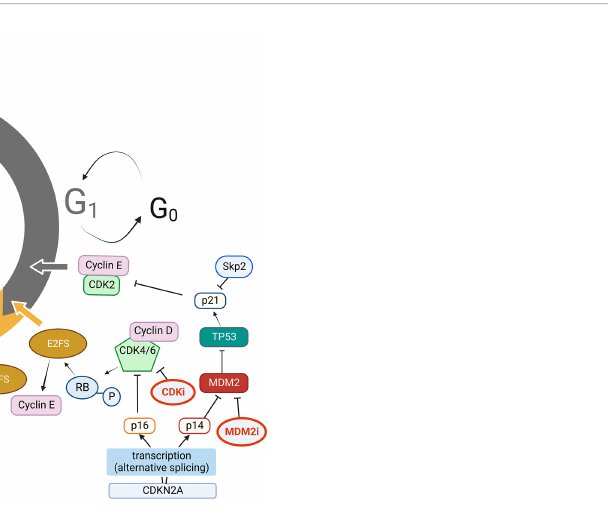
FIGURE 1 Key players in cell cycle dysregulation in STS. CDK, Cyclins, CKI, and other key molecular players in CDK activity/inhibition. Clockwise, starting from G1 to S phase progression: CDKN2A is transcribed by alternative splicing either into p16 or p14, which respectively inhibit CDK4/6/Cyclin D complexes and MDM2 activity. MDM2, an ubiquitin ligase, ubiquitinates p53 targeting it to the proteasome; p53 has p21 as a direct transcriptional target, and p21 in turn inhibits CDK2/Cyclin E complexes. Cyclin E expression is regulated by E2F transcription factor, which in turn is released from Rb protein grip (usually blocking its transactivation domain) when CDK4/6/Cyclin D complexes phosphorylate Rb, facilitating G1 to S phase progression. The ubiquitin ligase Skp2 targets p21 and p27 for proteasomal degradation, thus promoting CDK2/Cyclin E, CDK2/Cyclin A activity in S phase progression, CDK1/Cyclin A activity for G2 to M transition, which is also fostered by releasing p21 inhibitory activity on CDK1/Cyclin B; DUX4 can also bind CDK1, thus preventing CDK1/Cyclin B interaction. MDM2 activity can also be inhibited with MDM2 inhibitors (MDM2i), while CDK inhibitors (CDKi) currently in use in clinical practice are mainly CDK4/6 inhibitors. MDM2i and CDKi are highlighted in bold (red) in Figure 1. Created with